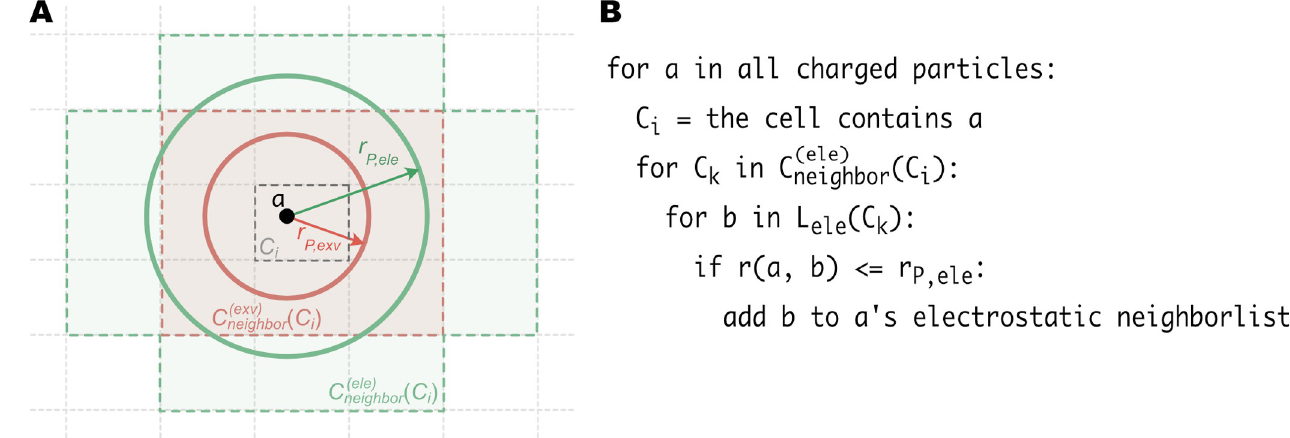
Fig 3. Using the cell linked list method to construct multiple neighbor lists. (A) An example of determining the neighbor list for E exv (representing either or E ð 2 Þ ) and E on a two-dimensional space. The gray dotted lines show the edges of the cells. The center cell with dark dashed edges ( C E ð 1 Þ ele exv exv particle a (black dot) whose neighbor list is to be determined. r P , exv and r P , ele are the neighbor-list distances for E exv and E ele , respectively. The neighboring cells term ( C ð exv Þ ð C Þ ) are represented by the red cells and surrounded by the red dashed lines. Those for the E for the E exv neighbor i area edged by green dashed lines. The red and green circles indicate the range of final neighbor lists for E exv and E ele , respectively. (B) Pseudo code of the algorithm to determine a neighbor list of the electrostatic interaction. L